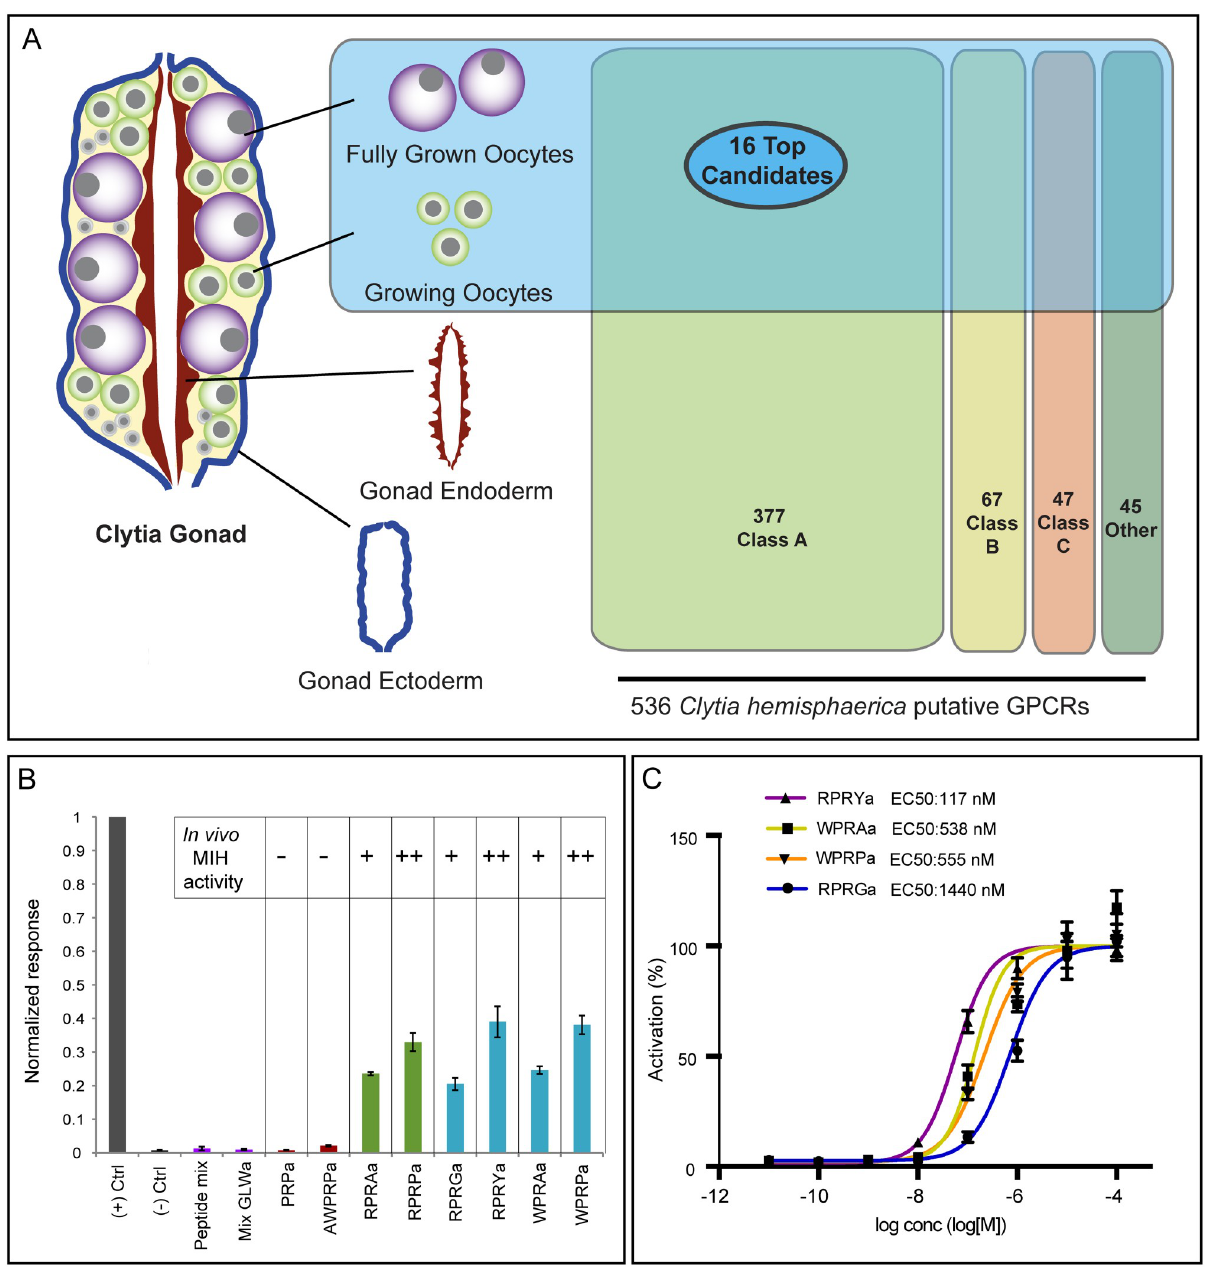
Fig 1. Identification of the Clytia MIHR. (A) Diagram of a Clytia gonad showing the different tissues used for RNA-seq and GPCR expression comparisons. A total of 536 putative GPCRs identified in Clytia mixed-stages transcriptome were assigned to the three main GPCR classes (A, B, C) or “other” based on Pfam signatures. The 16 top candidate MIH GPCRs were selected based on oocyte enrichment, relatedness to known bilaterian class- A neuropeptide GPCRs, and Pfam information. (B) Luminescence response of CHO-K1 cells expressing the putative Clytia MIH GPCR treated with neuropeptide mixes lacking MIH activity (purple bars), MIH tetrapeptides identified from C . hemisphaerica (blue bars) or Cladonema radiatum (green bars), or related penta- and tripeptides previously shown to be ineffective in triggering oocyte maturation in vivo (red bars) [15]. Empty pcDNA3.1 vector was used as negative control and Platynereis FLamide and its receptor as a positive control (gray bars). Peptide concentrations all 1 μ M. Absolute units of luminescence were normalized using the positive control; data are shown as mean ± standard error of the mean ( n = 3). Full datasets are available in S1 Data. MIH tetrapeptides were selectively able to activate the Clytia GPCR, the responses closely matching the in vivo MIH activity of each peptide tested on Clytia oocytes as indicated (summarized results from [15]). (C) Dose–response curves of Clytia MIHR challenged with four variant Clytia MIH tetrapeptides. One of three independent experiments with equivalent results is shown. Luminescence values were normalized relative to the maximum of fitted dose–response curves and are shown as mean ± standard error of the mean ( n = 3). Half maximal effective concentration (EC 50 ) values were calculated as means of 3 independent experiments. Full datasets from three independent experiments are available in S2 Data. CHO-K1, Chinese Hamster ovary K1; GPCR, G protein–coupled receptor; MIH, maturation-inducing hormone; MIHR, MIH receptor; RNA- seq, RNA